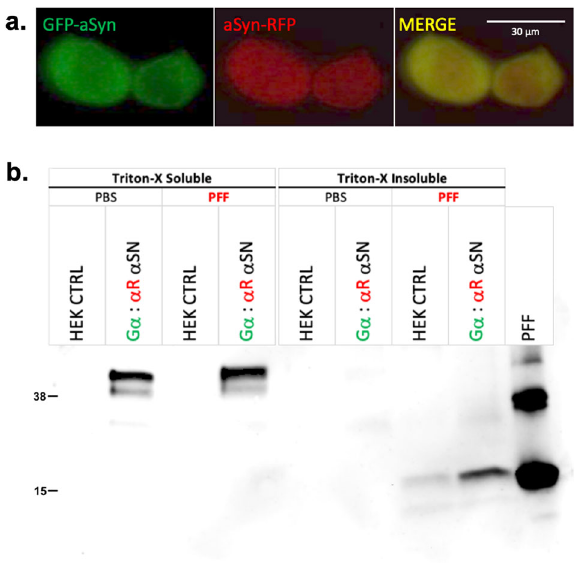
Fig. 2 Characterization of α SN cellular FRET biosensors. a Fluorescence live cell imaging of our inter-protomeric cellular FRET biosensors co-expressing GFP- α SN/ α SN-RFP constructs illus- trate a diffuse expression pro fi le (non-punctate). b To explore whether our biosensor FRET stems from soluble oligomers or fi brillary α SN, both control (HEK CTRL) and biosensor (G α : α R α SN) transfected HEK cells were treated with PFFs (400 ng) or vehicle (PBS) for 24 h. Immunoblots of Triton-X soluble and insoluble with 2% SDS extraction were probed with Syn1 antibody and showed that all biosensor fusion constructs were extracted in the soluble fraction for both PBS and PFF conditions, indicating that soluble protomer/oligomeric α SN is present in our α SN biosensors. From the blots, insoluble α SN derived from PFF is detected in PFF-treated TX- 100 insoluble fraction of cell lysate. See Supplementary Fig. 5 for loading